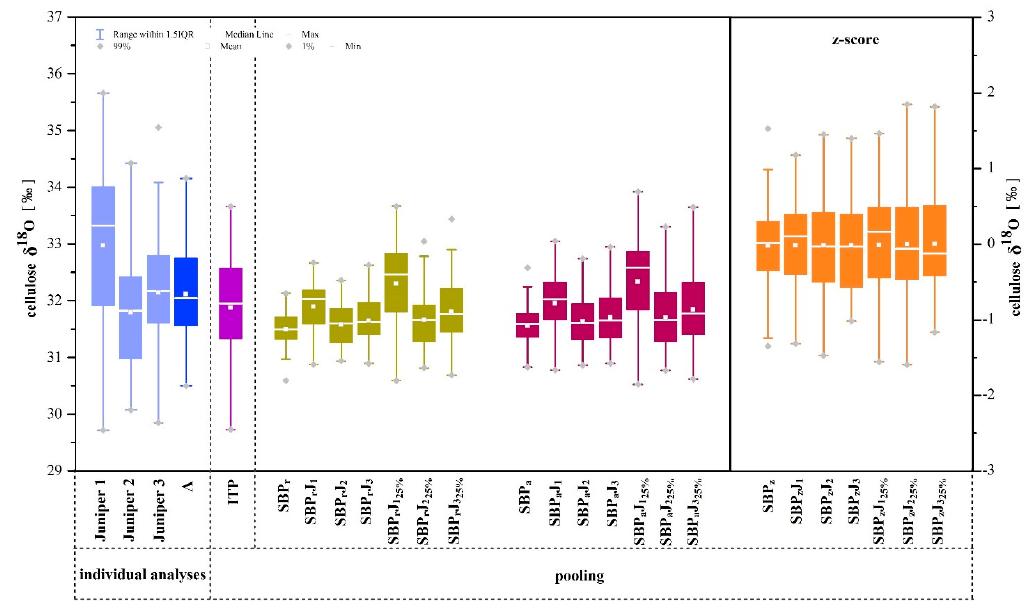
Figure 4. The statistical characteristics of the individual δ 18 O data series (juniper 1, juniper 2, juniper 3), the mean chronology (A), the inter-tree pooled chronology (ITP), and mean shifted serial pooled δ 18 O data series (SBP r , SBP r J 1 , SBP r J 2 , SBP r J 3 , SBP r J 125% , SBP r J 225% , and SBP r J 325% ), (SBP a , SBP a J 1 , SBP a J 2 , SBP a J 3 , SBP a J 125% , SBP a J 225% , and SBP a J 325% ), (SBP z ,SBP z J 1 , SBP z J 2 ,SBP z J 3 , SBP z J 125% , SBP z J 225% , and SBP z J 325% ).